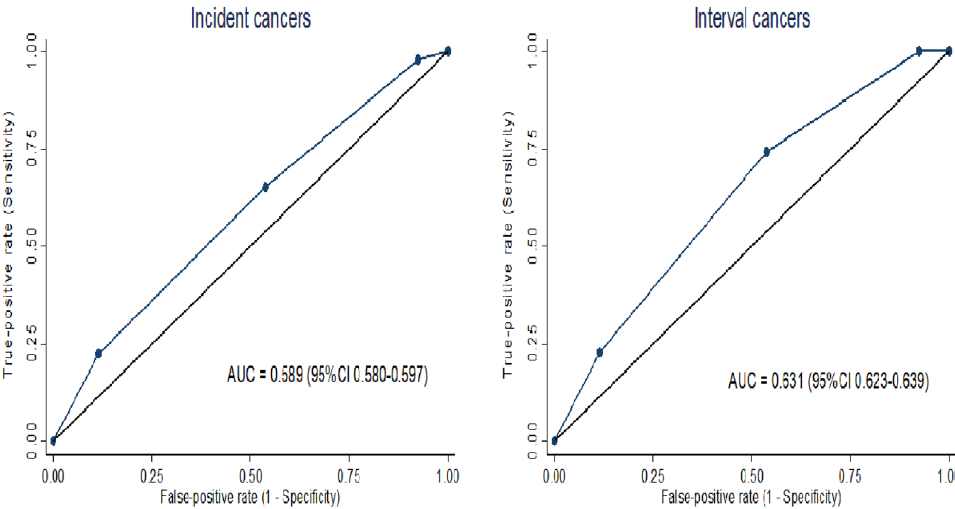
Figure 2. AUC for DenSeeMammo™ for incident and interval cancers (only RETomo and Florence).